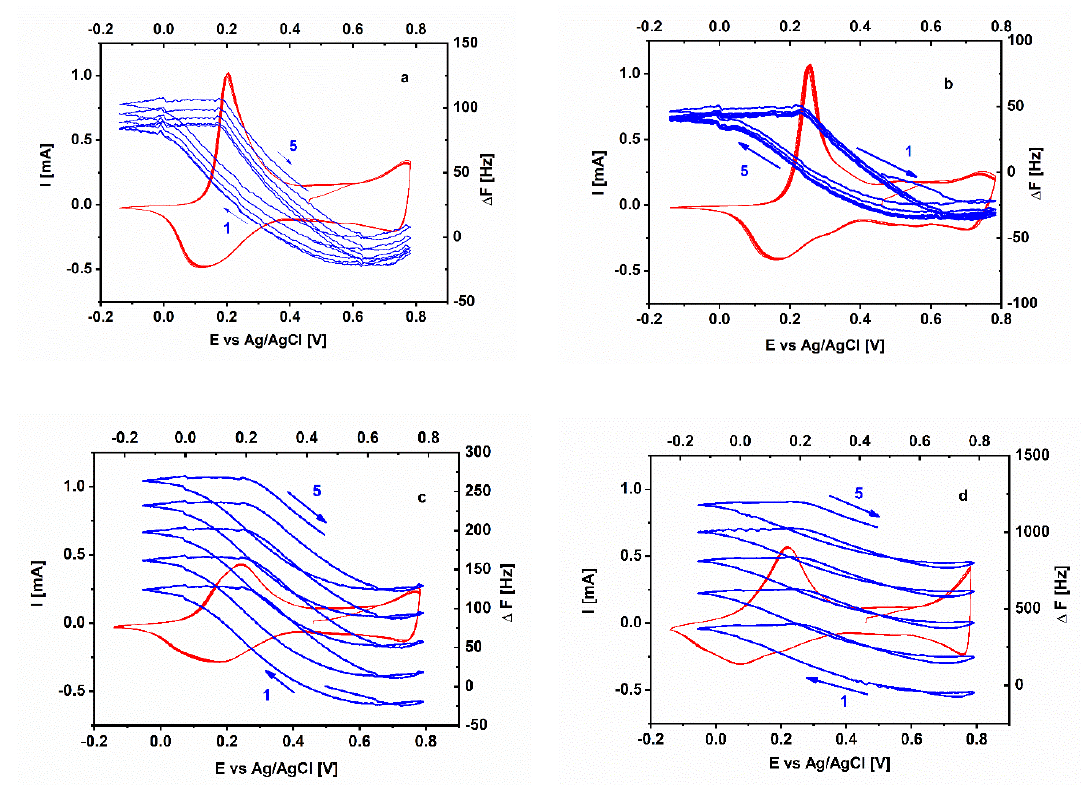
Figure 5. Simultaneous electrochemical (red) and microgravimetric (blue) measurements in the course of five voltammetric scans for ( a ) t-PASA; ( b ) i-PASA; ( c ) PSSA; ( d ) PAMPSA.